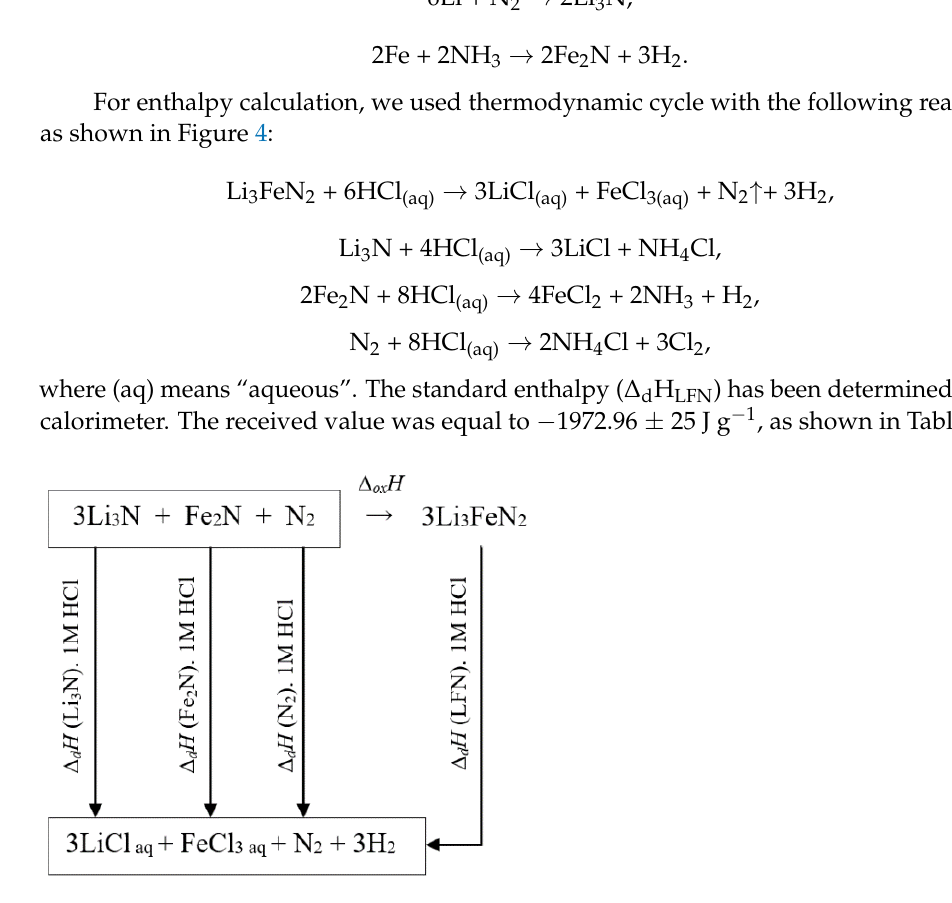
Figure 4. Thermochemical cycle scheme. Dissolution enthalpy connection of Li 3 FeN 2 with its formation enthalpies from single nitrides.